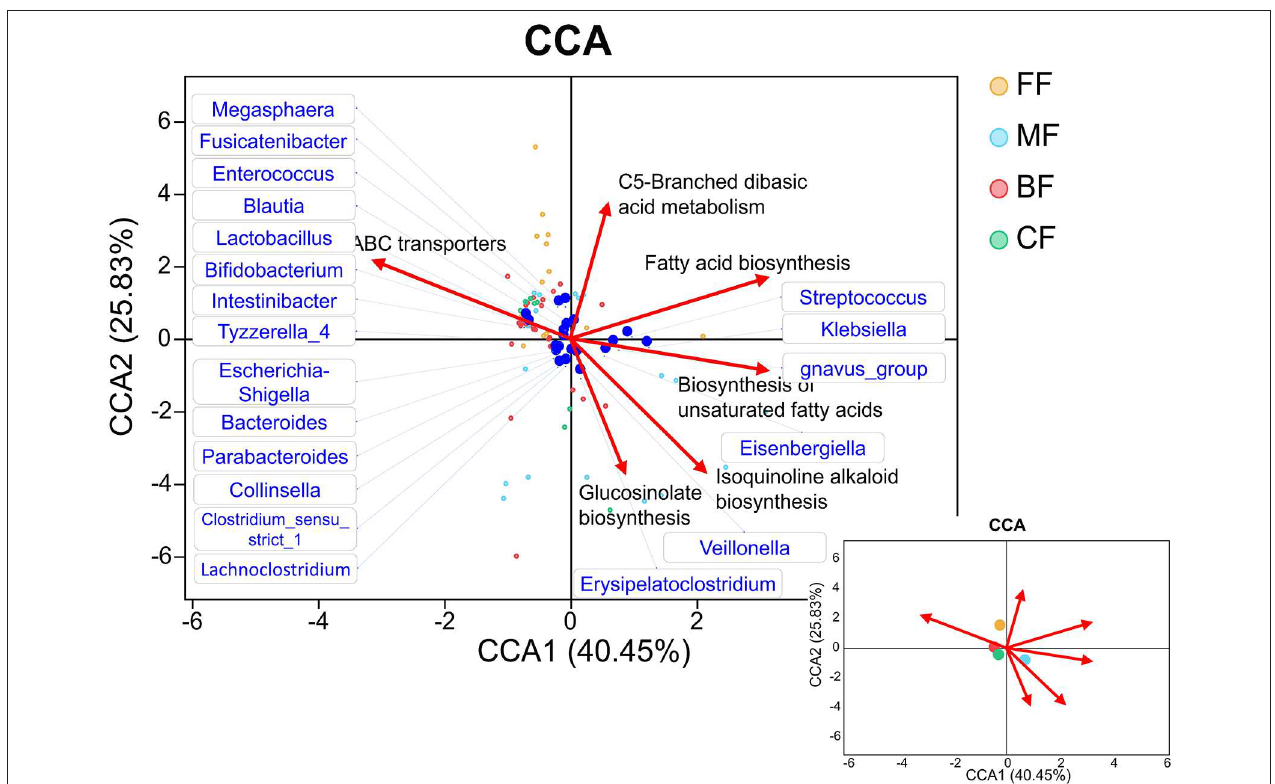
FIGURE 8 | Canonical correspondence analysis (CCA) diagram that showed the associations between infant feeding, gut microbiota, and metabolites. The blue dots represent the gut microbiota correlated with the pathways; the lower right picture shows the relationship between pathways and groups.